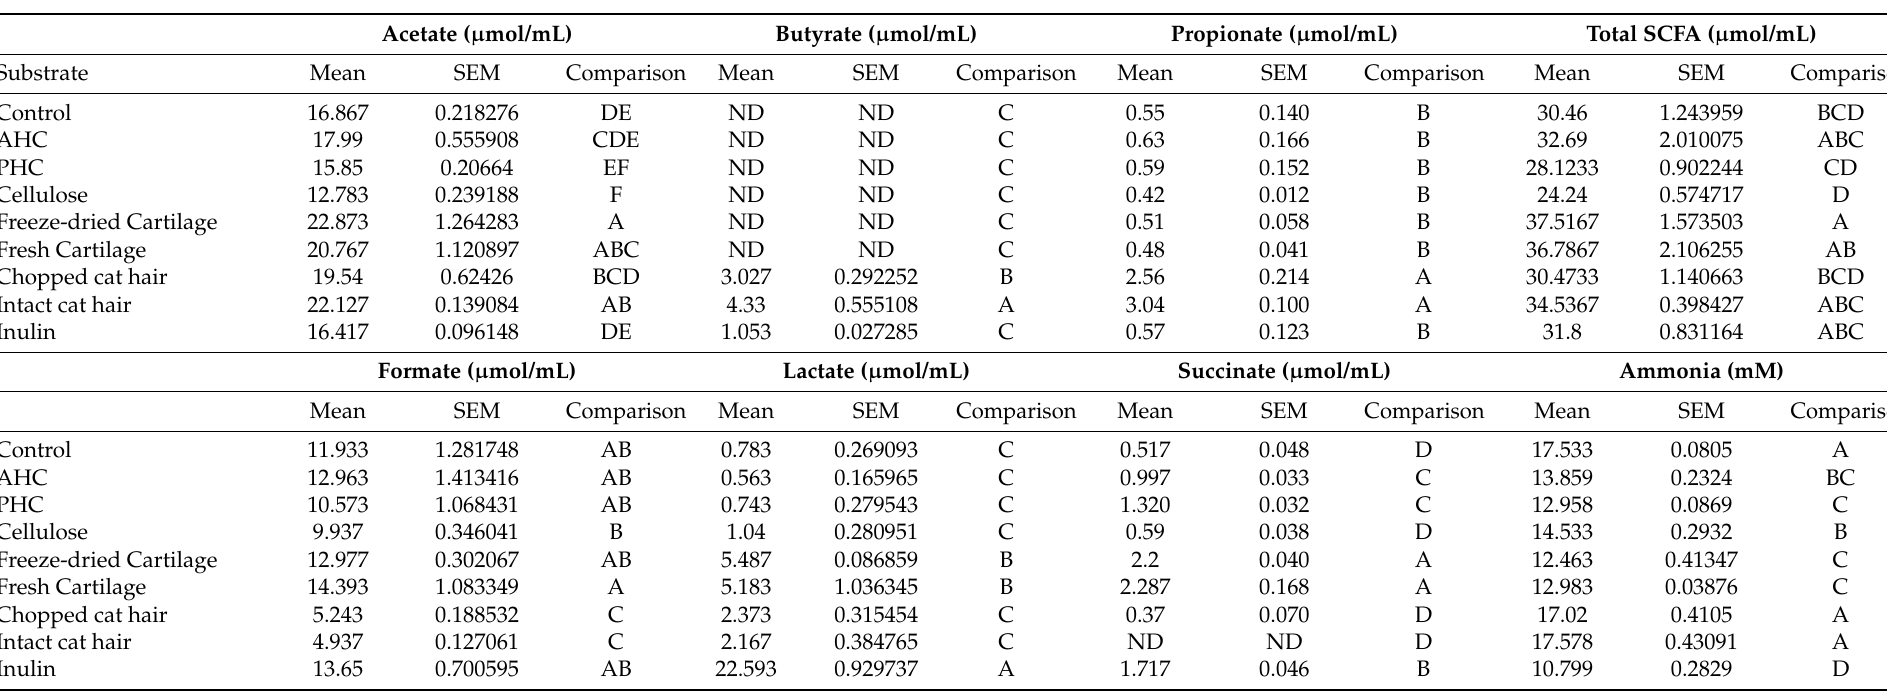
Table 3. Predicted means and associated standard error of the mean of organic acids and ammonia concentrations following in vitro fermentation of each substrate at the 24-h time point in the CD (high carbohydrate) faecal inoculum. Letter-based representation of pairwise comparisons is presented. Different letters indicate differences at significance level 0.05, adjusted using the Tukey method. AHC; ANZCO hydrolysed collagen. PHC; Peptan hydrolysed